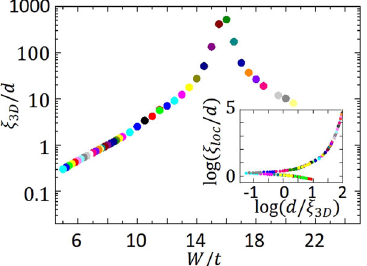
Fig. 5 Evolution of the 3D localization length ξ loc with the disorder. Each color corresponds to a given disorder W . ξ 3D is the bulk localization length, d is the sample thickness, and t is the kinetic energy of the electrons. There is a localized − delocalized transition around a critical disorder W c ≈